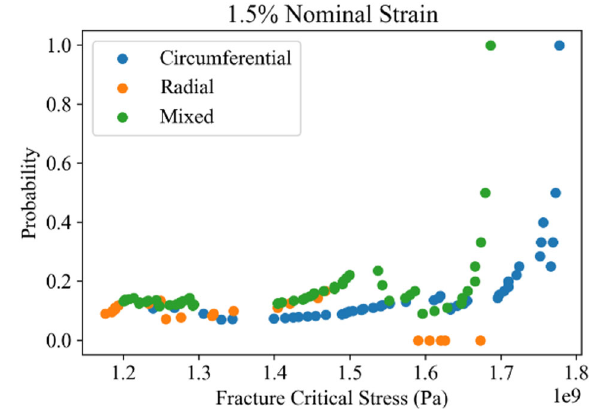
Fig. 5 Bayesian crack probability analysis for 1.50% nominal